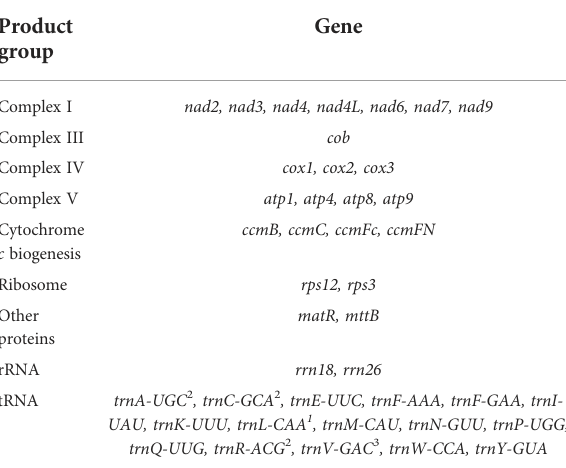
TABLE 1 Known functional genes in the three Broussonetia spp.